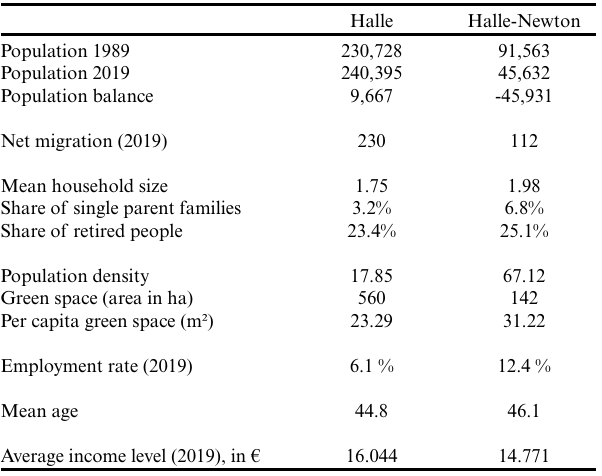
Table 1 . Basic information for the city of Halle and Halle- Newtown as the case study area for data collection (own compilation based on Halle census and municipal statistical data).